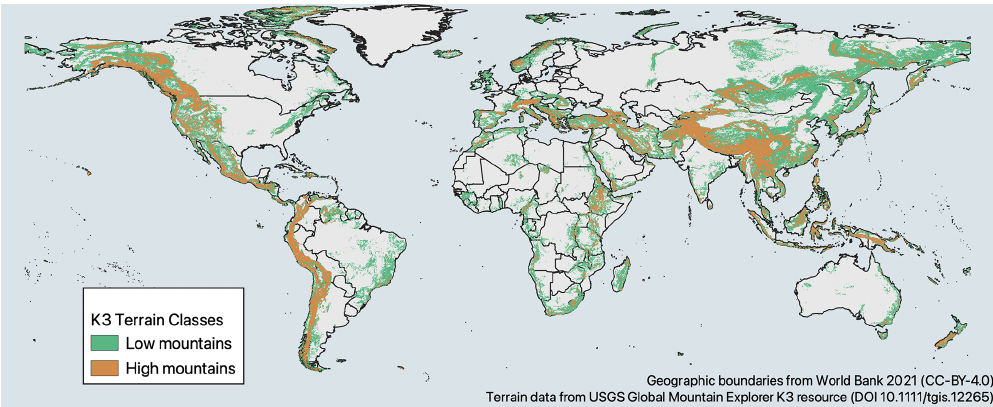
Figure 1. Around 30% of the global land surface can be considered to be mountainous. Data are plotted by the authors from the Global Mountain K3 data files (Karagulle et al., 2017). The definition of mountainous terrain used for this figure is provided in Appendix A. An interactive version of the map is available at https://rmgsc.cr.usgs.gov/gme/gme.shtml (last access: 1 October